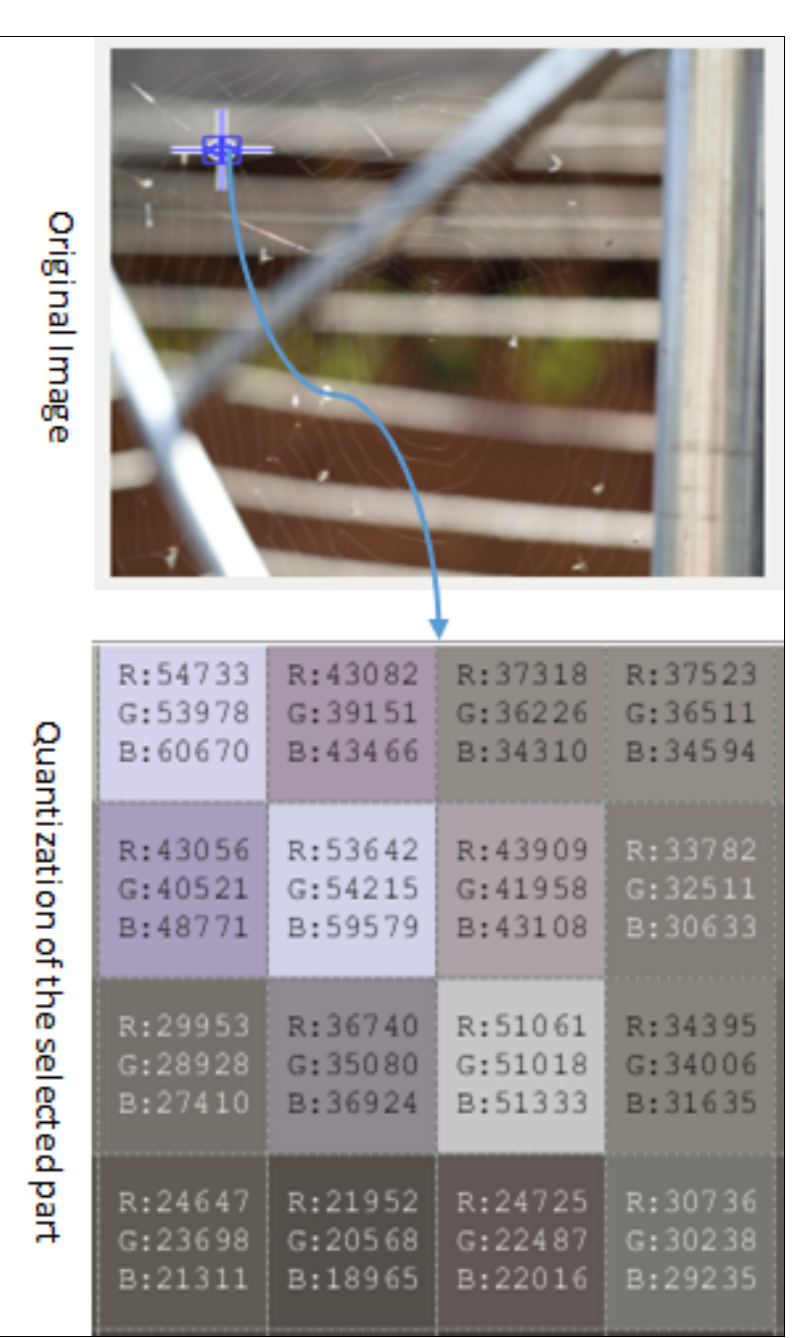
Figure 5. A 16-bit RGB